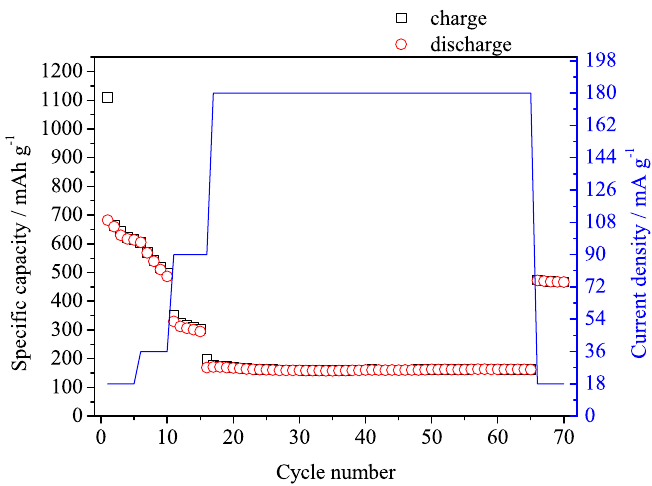
Figure 8. Specific capacity versus the cycle number of SnO x /CHI electrode material at different current